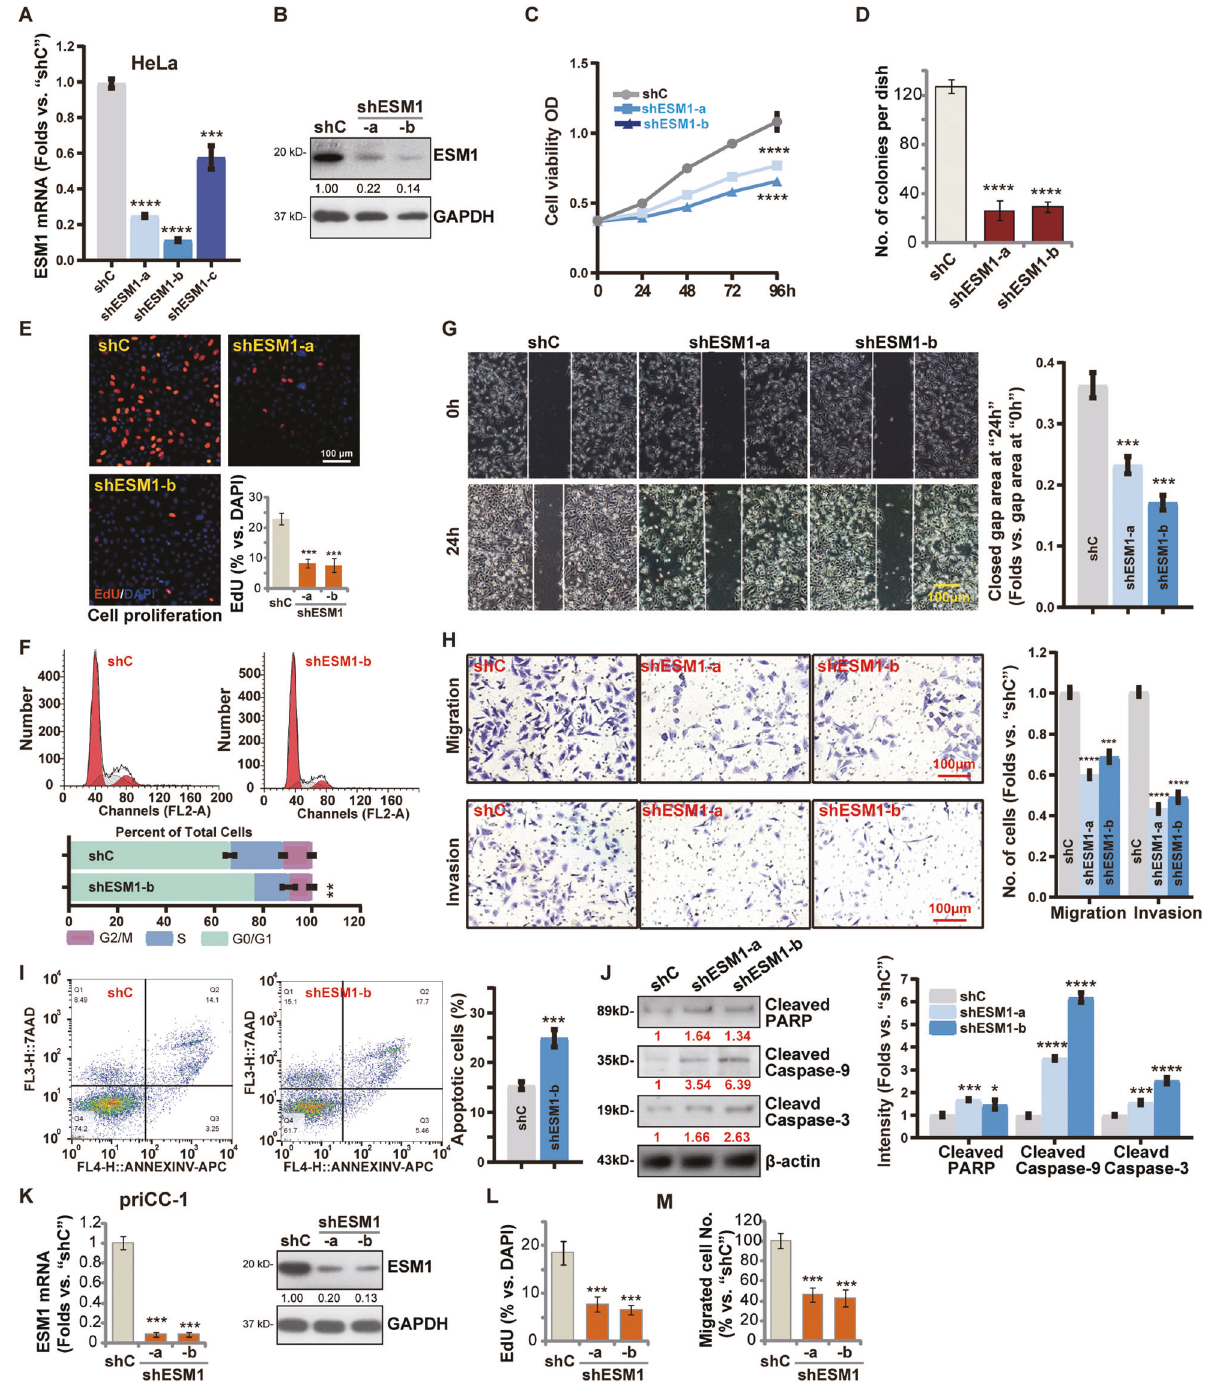
Fig. 2 ESM1 knockdown inhibits cervical cancer cells progression. Established cervical cancer cell line (HeLa) ( A – J ) and primary cervical cancer cells ( “ priCC-1 ” ) ( K – M ) that expressed the ESM1 shRNA (shESM1-a/shESM1-b/shESM1-c) or the scramble control shRNA ( “ shC ” ) were established and cultured. The effects of ESM1 knockdown were con fi rmed by qRT-PCR ( A and K ) and Western blotting ( B and K ), GAPDH was used as an internal control. Cell viability was tested by CCK8 assay. The OD value was detected at 0 h, 24 h, 48 h, 72 h, and 96 h ( C ). Cell growth was tested by colony formation assay ( D ). EdU staining was used for cell proliferation ( E and L ). Three random views ( n = 3) of total 1, 000 cell nuclei per each condition were used to calculate the average EdU ratio (% vs. DAPI), and same for all EdU studies. Cell cycle progression was detected by fl ow cytometry ( F ). Wound-healing assay was used to examine the migration effect of ESM1 ( G ). The wound space was photographed at 0 h, and 24 h ( G ). Cell migration and invasion were tested by Transwell and Matrigel Transwell assays ( H and M ). Three random microscopy views were included to calculate the average number of migrated or invaded cells in each condition (same for all “ Transwell ” assays). Apoptosis was detected by fl ow cytometry ( I ). Caspase-PARP activationwas tested by Western blotting assay ( J ). The data were presented as mean ± standard deviation (SD, n = 3). * P < 0.05, ** P < 0.01, *** P < 0.001, **** P < 0.0001 vs. “ shC ” cells. The experiments were repeated three times with similar results obtained. Scale bar = 100 μ m.